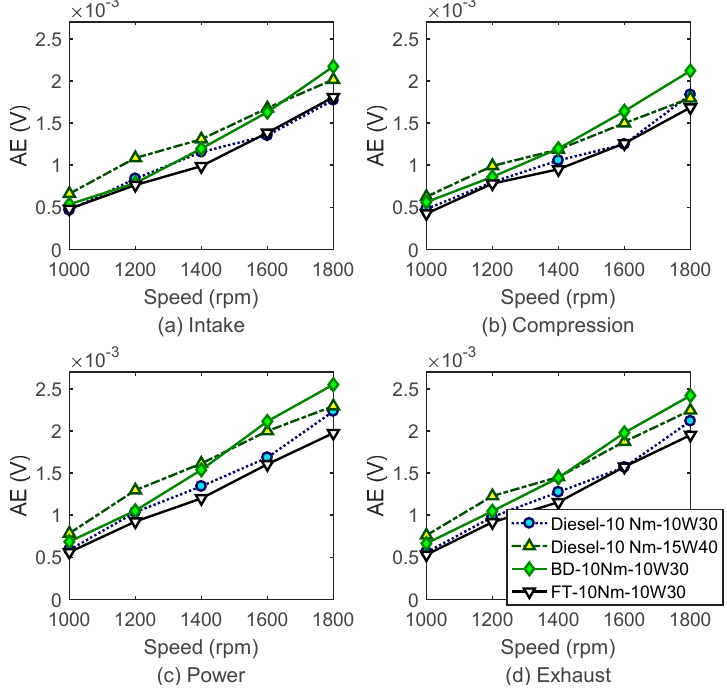
Figure 12. FAS–AE indicators of different fuels under low load: ( a ) Intake; ( b ) Compression; ( c ) Power; ( d ) Exhaust.